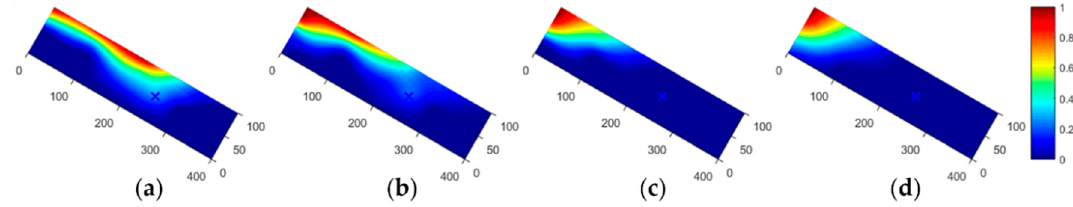
Figure 8. The gas distribution at different shut-in times of Exp4. ( a ) 24 h after shut-in; ( b ) 48 h after shut-in; ( c ) 72 h after shut-in; ( d ) 96 h after shut-in.